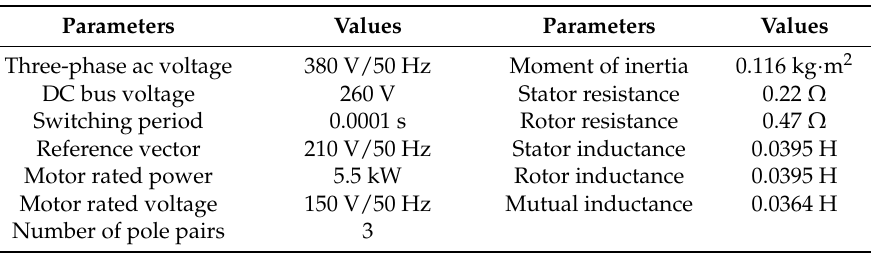
Table 2. Simulation and experiment